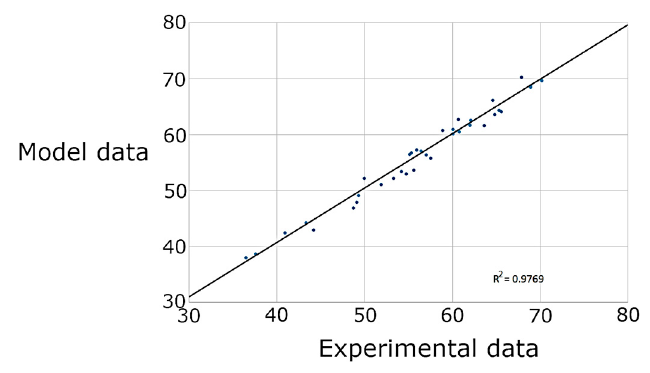
Figure 5. Goodness of fit between experimental and model data for separation efficiency.